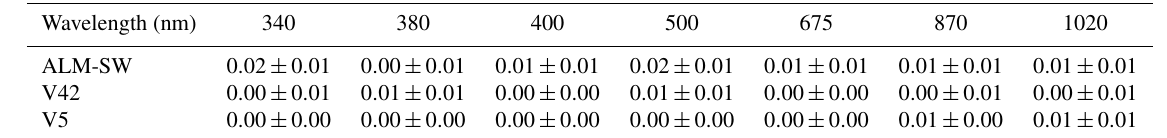
Table 5. Means and standard deviations of differences between the DAOD (aerosol optical depth derived from the direct irradiance) and the aerosol optical depth of ALM-SW, V42, and V5.